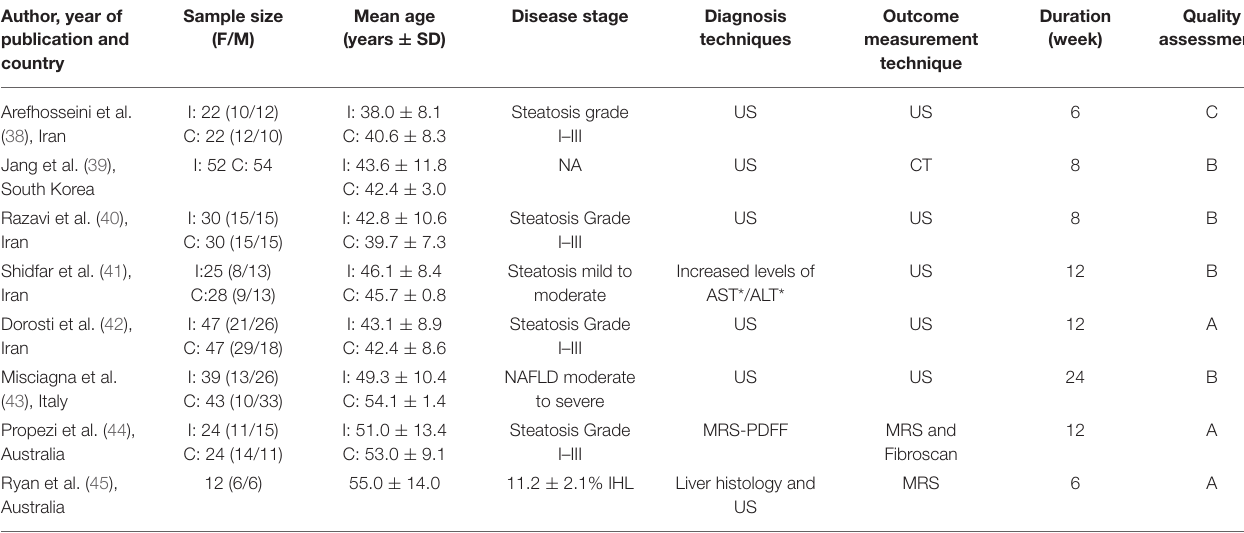
TABLE 1 | Characteristics and quality assessment results of the included studies.